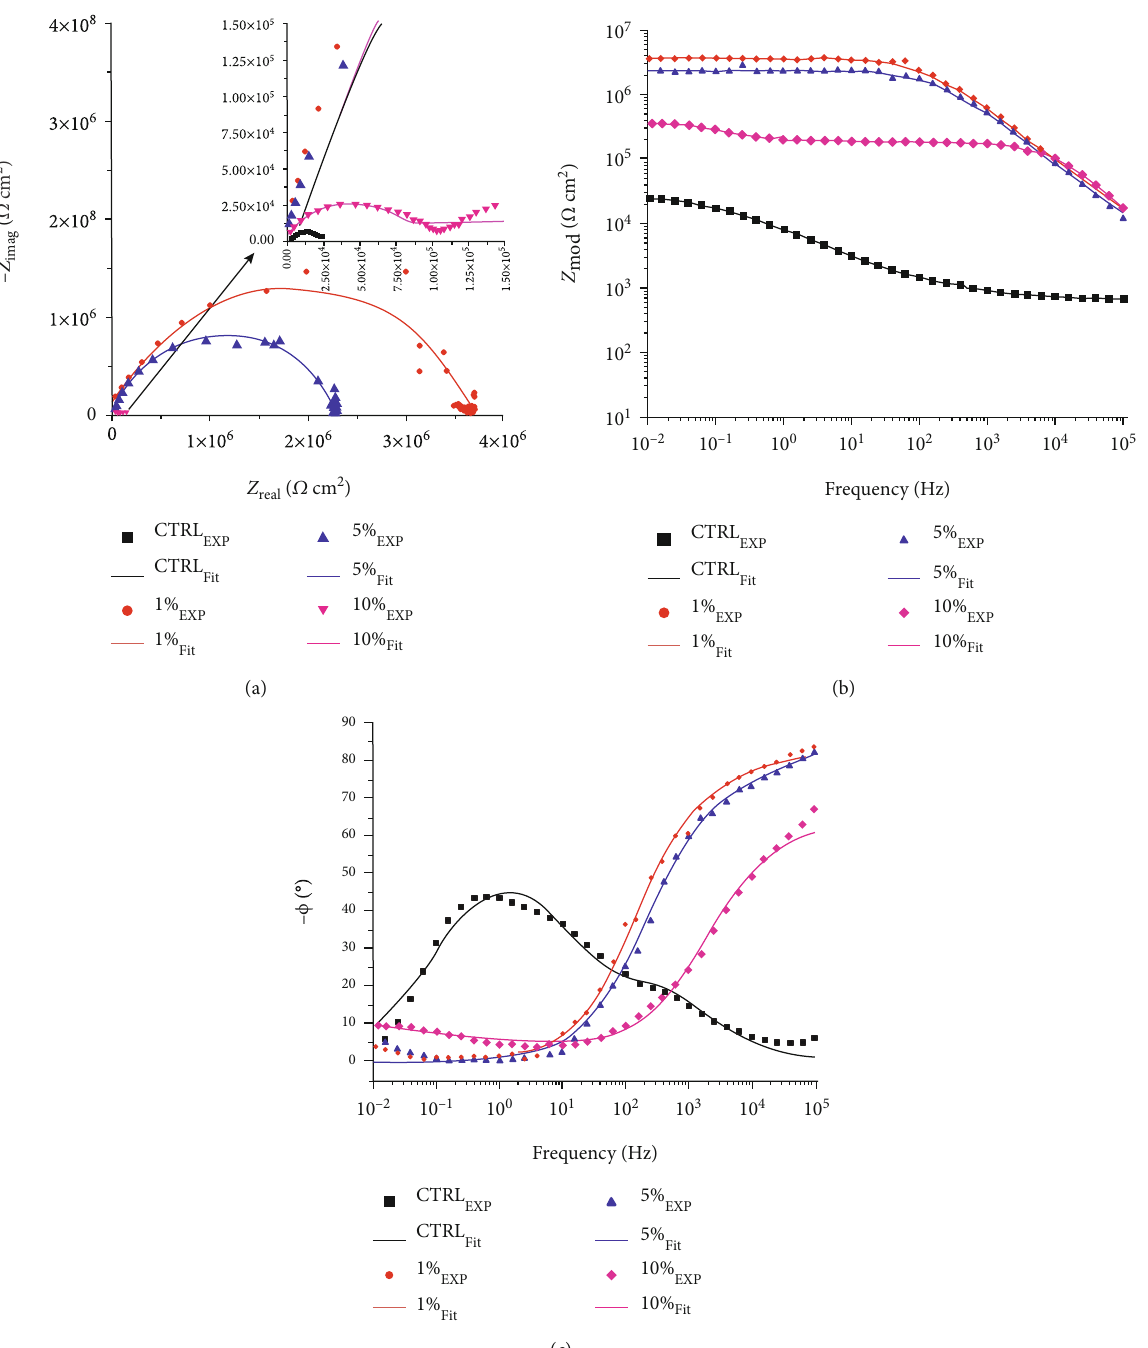
Figure 9: (a) Nyquist, (b) Bode modulus, and (c) Bode phase, plots of the scratched control and MC contained coatings after 14 days of immersion in 3.5% NaCl solution (0.785cm 2 circular contact area).